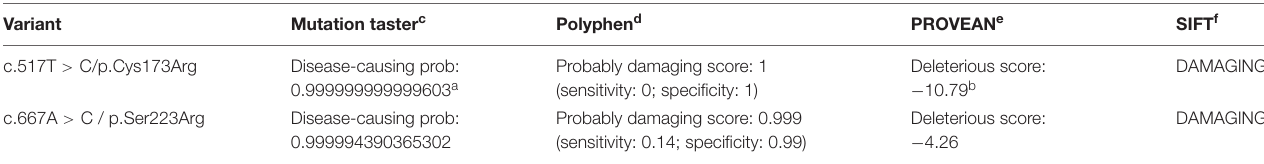
TABLE 2 | Functional predictions of the two mutations of AGXT in this